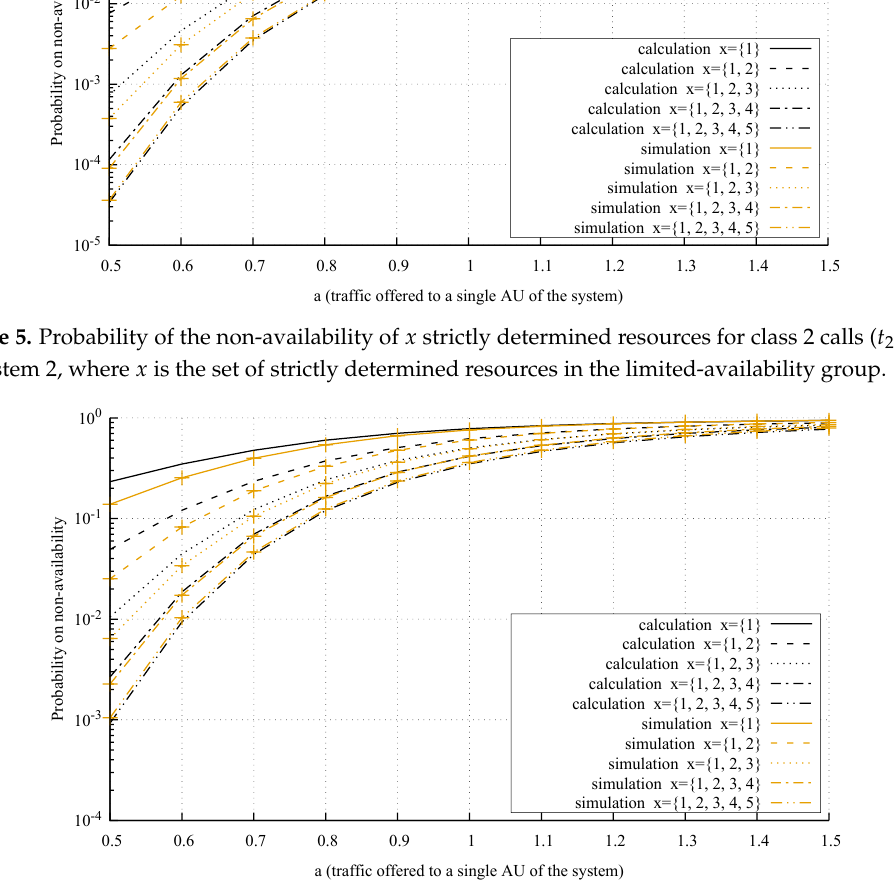
Figure 6. Probability of the non-availability of x strictly determined resources for class 3 calls ( t 3 = 5) in System 2, where x is the set of strictly determined resources in the limited-availability